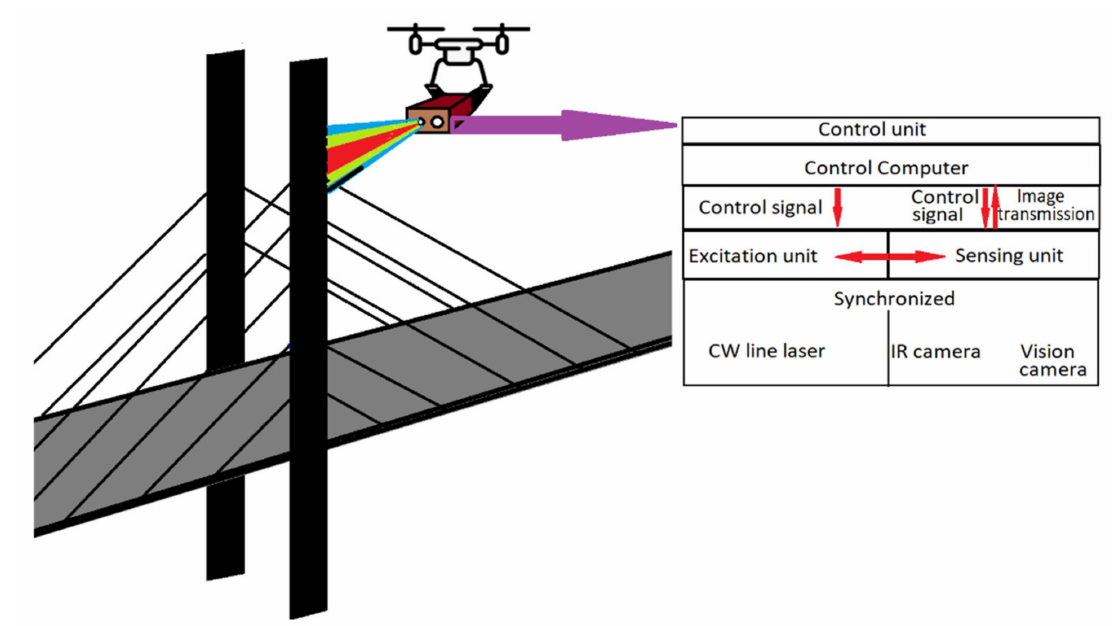
Figure 4. Schematics of the proposed hybrid image scanning (HIS) system [30].